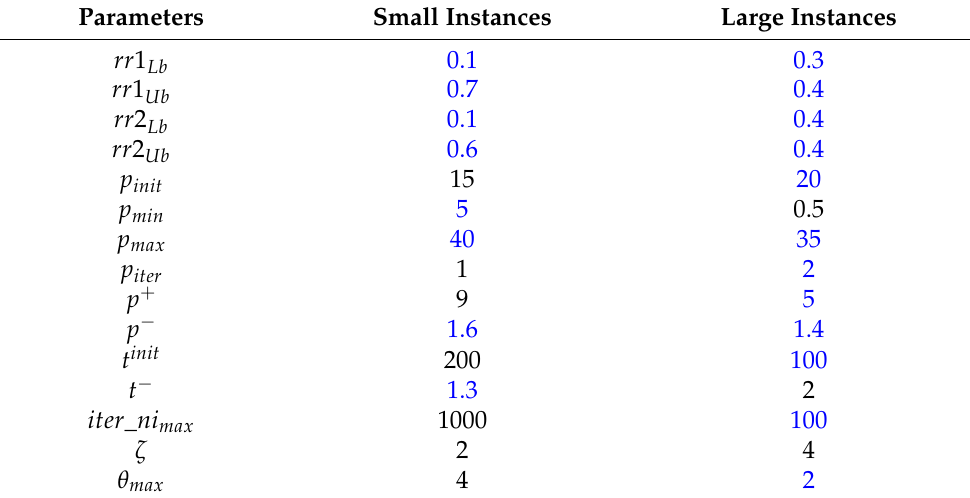
Table 4. Parameter values determined by irace for